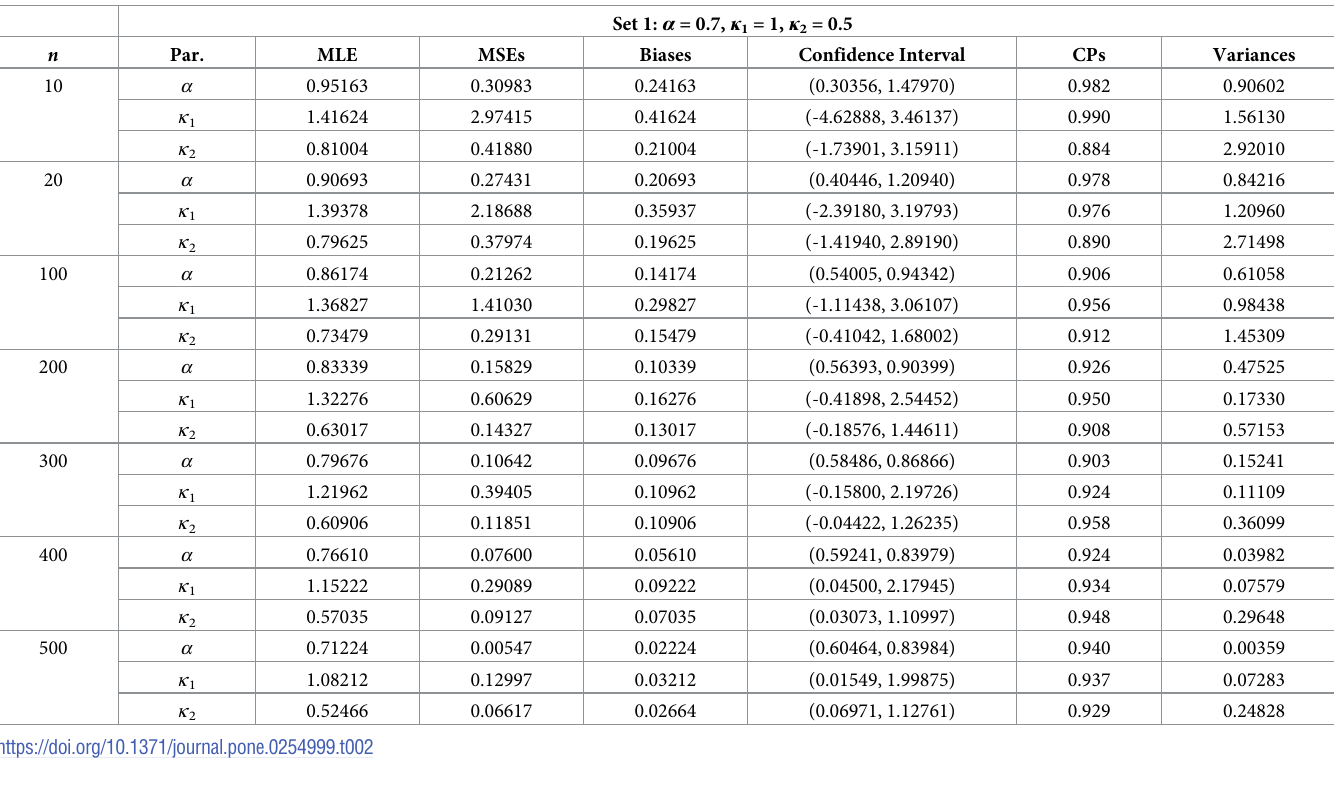
Table 2. The Monte Carlo simulation results of the ASM-Weibull